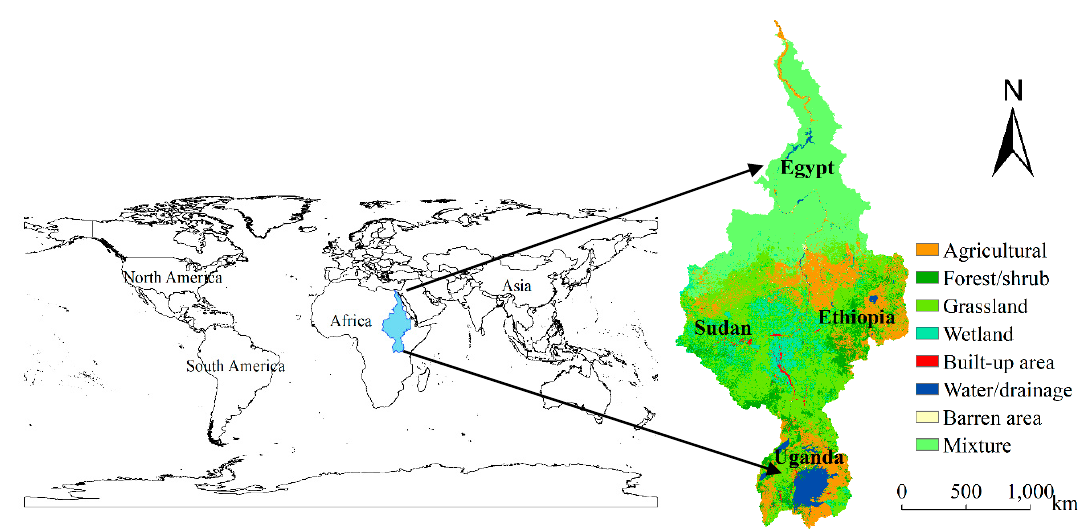
Table 1. Quantitative numbers on all Revised Universal Soil Loss Equation (RUSLE) factors.